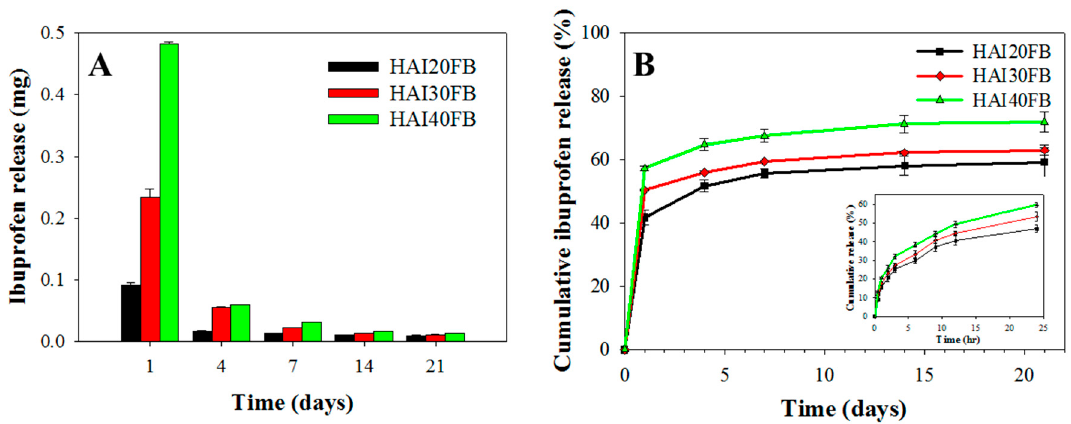
Figure 4. The released weight ( A ) and cumulative release percentage ( B ) of IBU from HAI20FB, HAI30FB, and HAI40FB NFMs. The insert in ( B ) is the release percentage of IBU within 24 h.